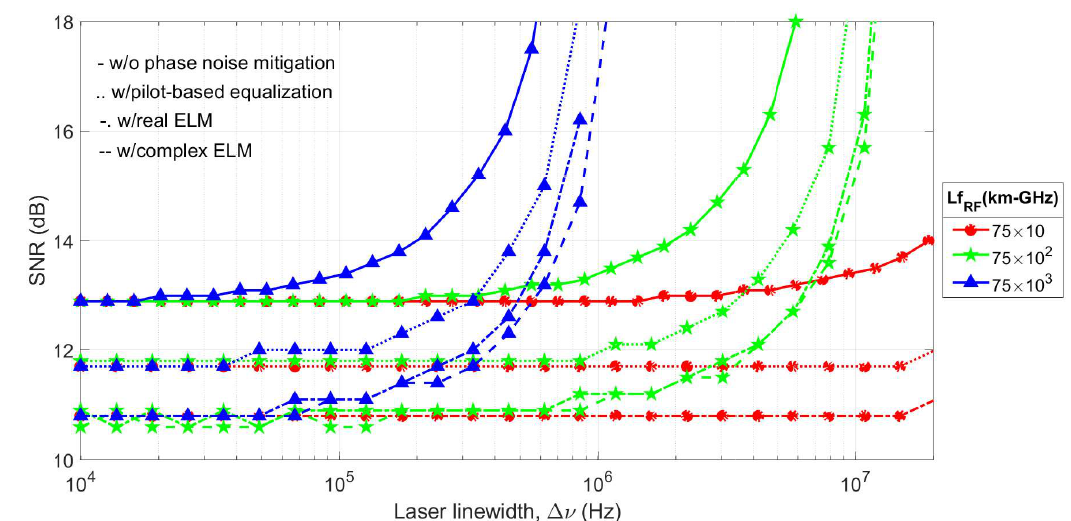
Figure 11. Taking into account various products between the fiber length and radio frequency (time delays), the SNR and laser linewidth requirements at the BER limit for the considered phase noise reduction